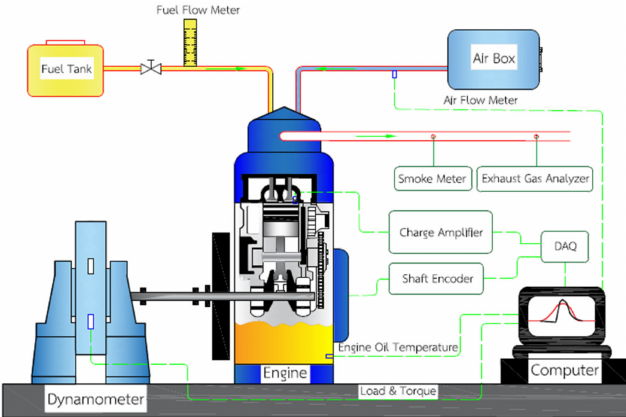
Figure 1. Experimental setup for engine testing.